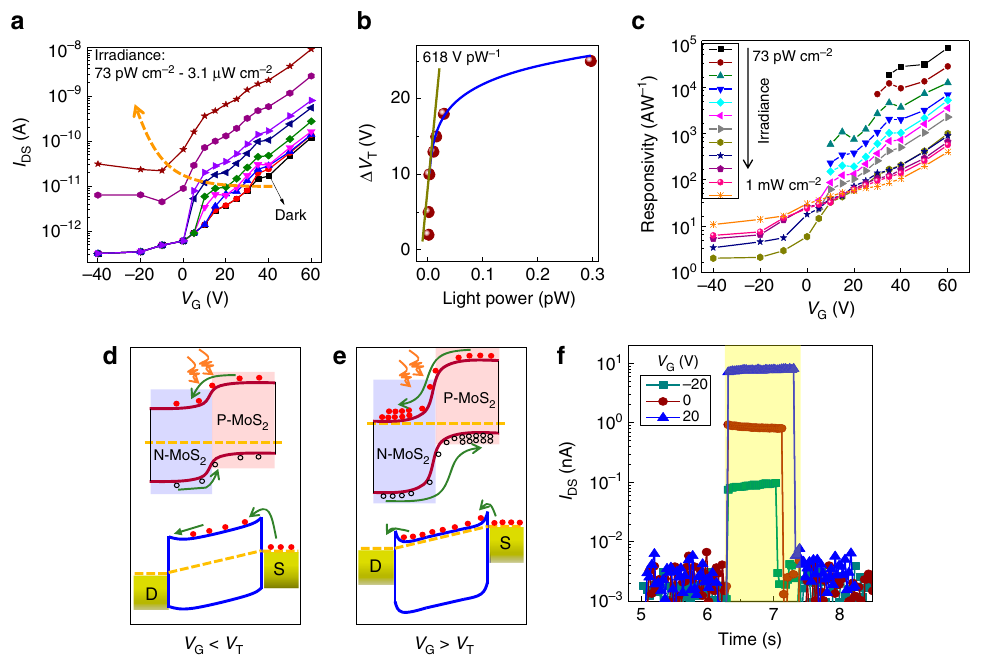
Fig. 2 Underlying mechanism of photodetection in the detector. a Back-gate dependence of drain current under dark and different irradiance intensities, the orange dash arrow shows the V T shift towards negative gate voltage with increasing illumination intensity due to the photo-gating effect. b V T shift ( Δ V T ) as a function of light power on the detector, the blue line is the non-linear fi tting at relatively high light power regime and the dark yellow line shows a slope as high as 618 V pW − 1 at low light power. c Responsivity of the device as a function of back gate at V DS of 10 V and under varying irradiance, demonstrating the increased responsivity and more sensitive detection capability by applying large-positive gate voltage. d Energy band diagram of the out-of-plane PN junction at the interface ( top panel ) and the N-MoS 2 transport channel ( bottom panel ) with applied bias under V G < V T . e The same with d but under V G > V T showing the more ef fi cient charge separation and recirculation due to the larger built-in fi eld and negligible contact barrier. f Temporal response of the device at different back-gate voltage and V DS of 10 V and under irradiance of 31.7 µ W cm −